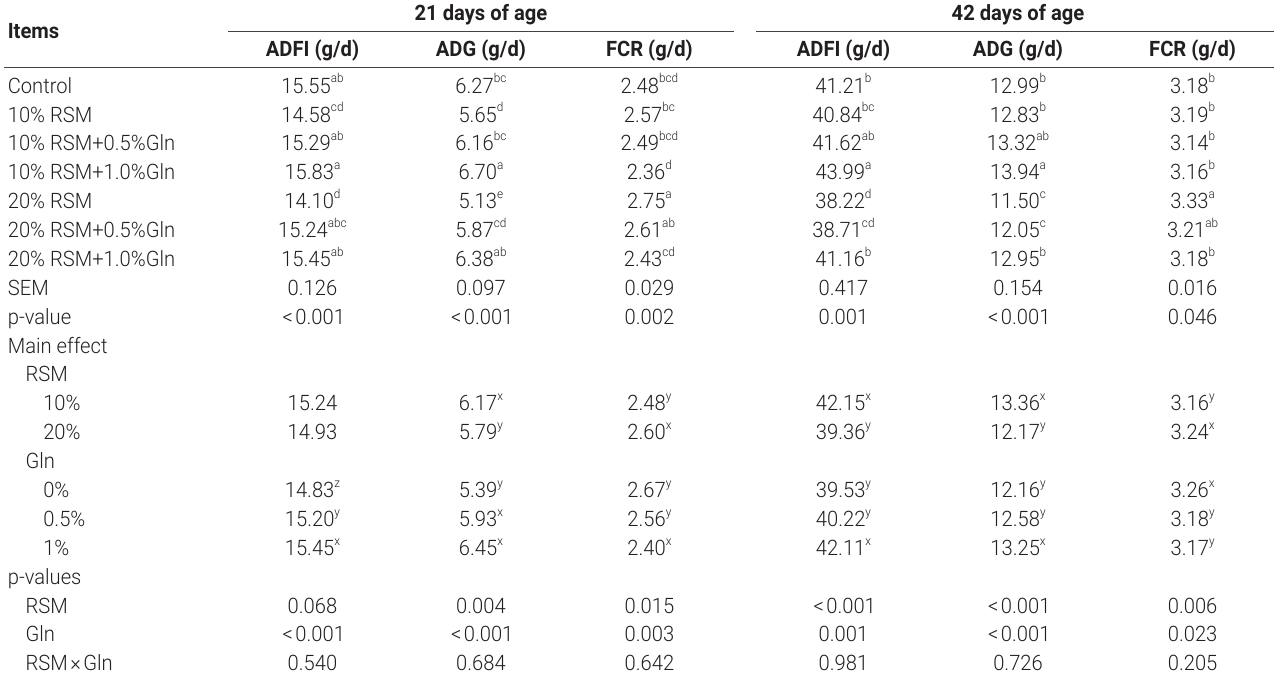
Table 3. Effects of different levels of rapeseed meal substitution and glutamine supplementation on the growth performance of Qiandongnan Xiaoxiang chicken